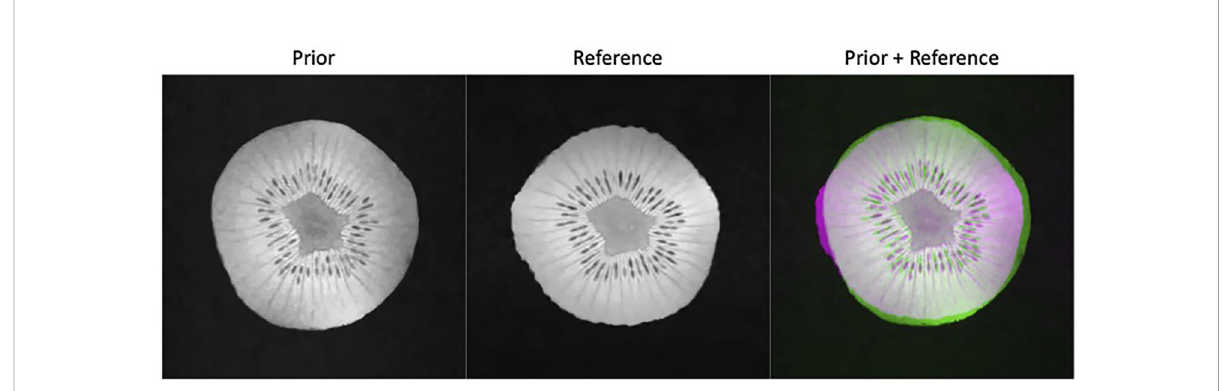
FIGURE 4 Prior kiwi image (left), the reference image for testing (middle), and the overlay of the prior (green) and reference (magenta) illustrating the deformations